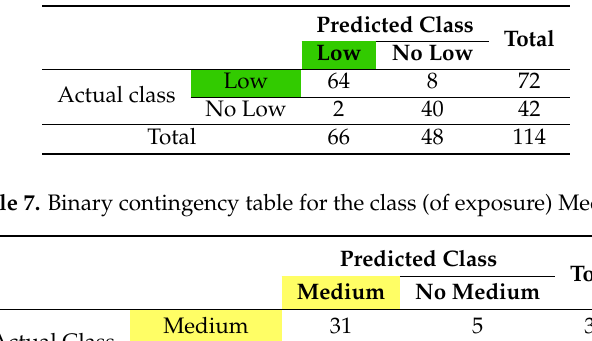
Table 6. Binary contingency table for the class (of exposure) Low.